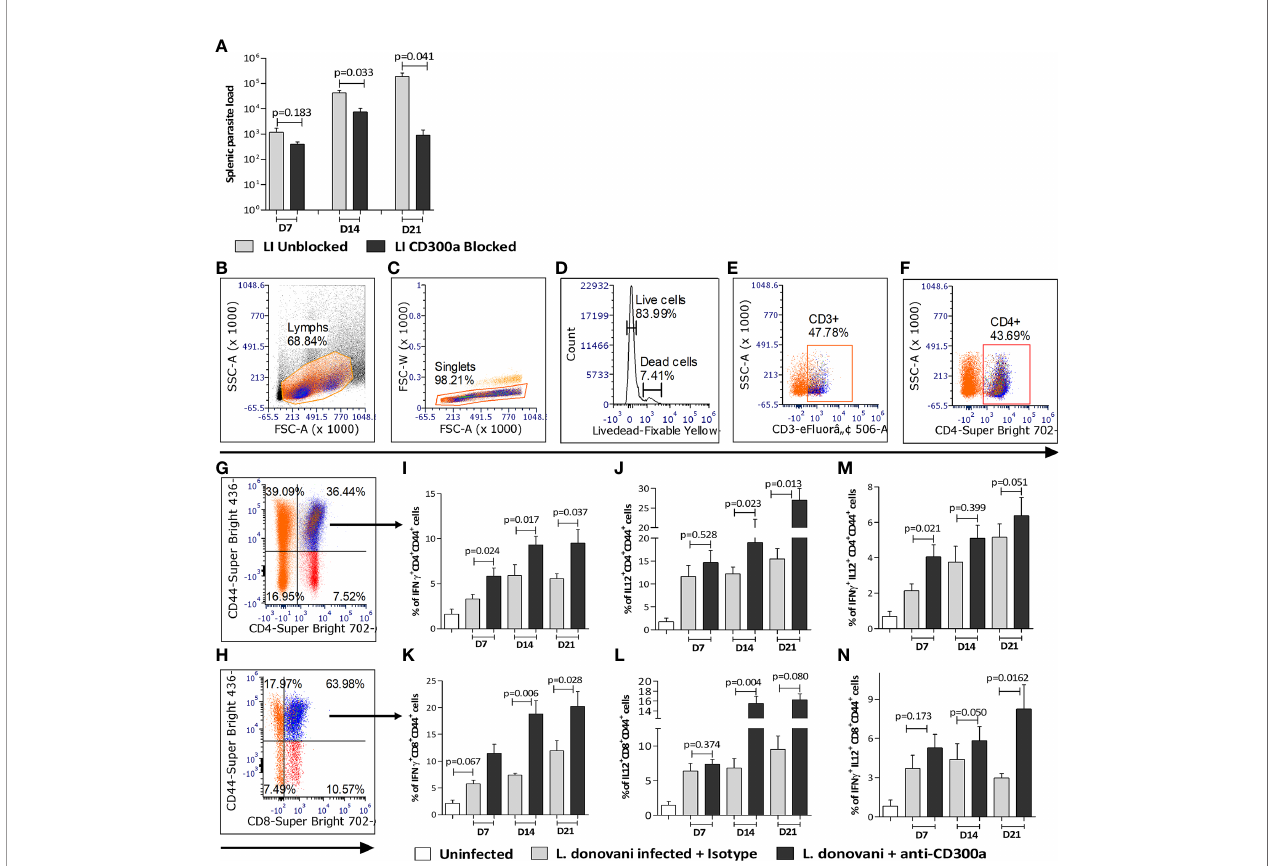
FIGURE 5 | Spleen parasite load and pro-in fl ammatory cytokines producing antigen experienced CD4 + and CD8 + T cells in anti-CD300a antibodies treated mice. (A) The CD300a receptor blocking signi fi cantly reduced (at D14 and D21) splenic parasite load. (B-H) Flow cytometry gating strategies to select antigen experienced CD4 + and CD8 + T cells. The CD4 + and CD8 + T cells were gated on CD3 + T cells, which were selected on live cells as shown in panels (B-F) . The cytokines secreting CD4 + and CD8 + T cells were gated on CD4 + CD44 + (G) and CD8 + CD44 + T cells (H) . In CD300a blocked animals, the CD4 + T cells expressing IFN- g + (I) , IL-12 + (J) , and CD8 + T cells expressing IFN- g + (K) , IL-12 + (L) were signi fi cantly increased. The IFN- g and IL-12 double-positive, CD4 + , and CD8 + T cells were also increased in antibody treated animals (M, N) . The isotype antibodies treatment group was used as a control to determine statistical signi fi